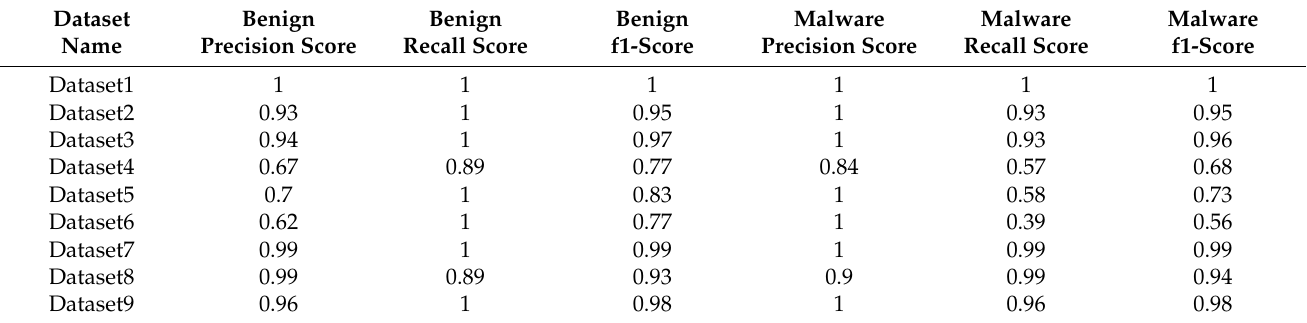
Table 14. Predication results when using the RF algorithm with minimum features.